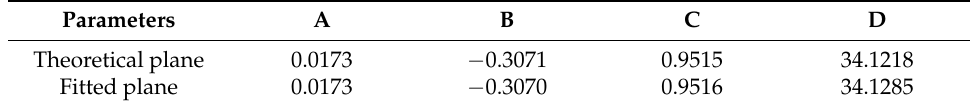
Table 1. The parameters of the simulated plane.